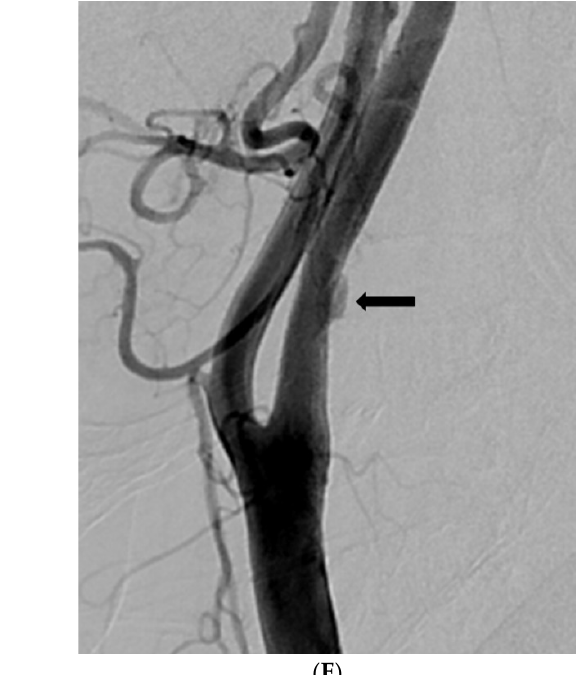
Figure 2. An 80-year old man with recurrent embolic stroke and symptomatic nonstenotic carotid disease. ( A ) Diffusion-weighted imaging shows diffusion restriction in right parietal white matter (arrows). ( B ) Carotid MR angiography shows mild stenosis of right proximal internal carotid artery. ( C ) SNAP imaging shows bilateral carotid intraplaque hemorrhage (arrows) and <50% carotid stenosis. ( D ) Carotid angiography shows focal ulceration of right carotid plaque (arrow). ( E ) Diffusion- weighted imaging shows multifocal and extended embolic infarction of right middle cerebral artery territory after one year. ( F ) Carotid angiography after recurrent embolic infarction showed increased ulceration and no interval change of stenosis (arrow). Table 3. Univariate and multivariable analysis associated with SyNC and ESUS.